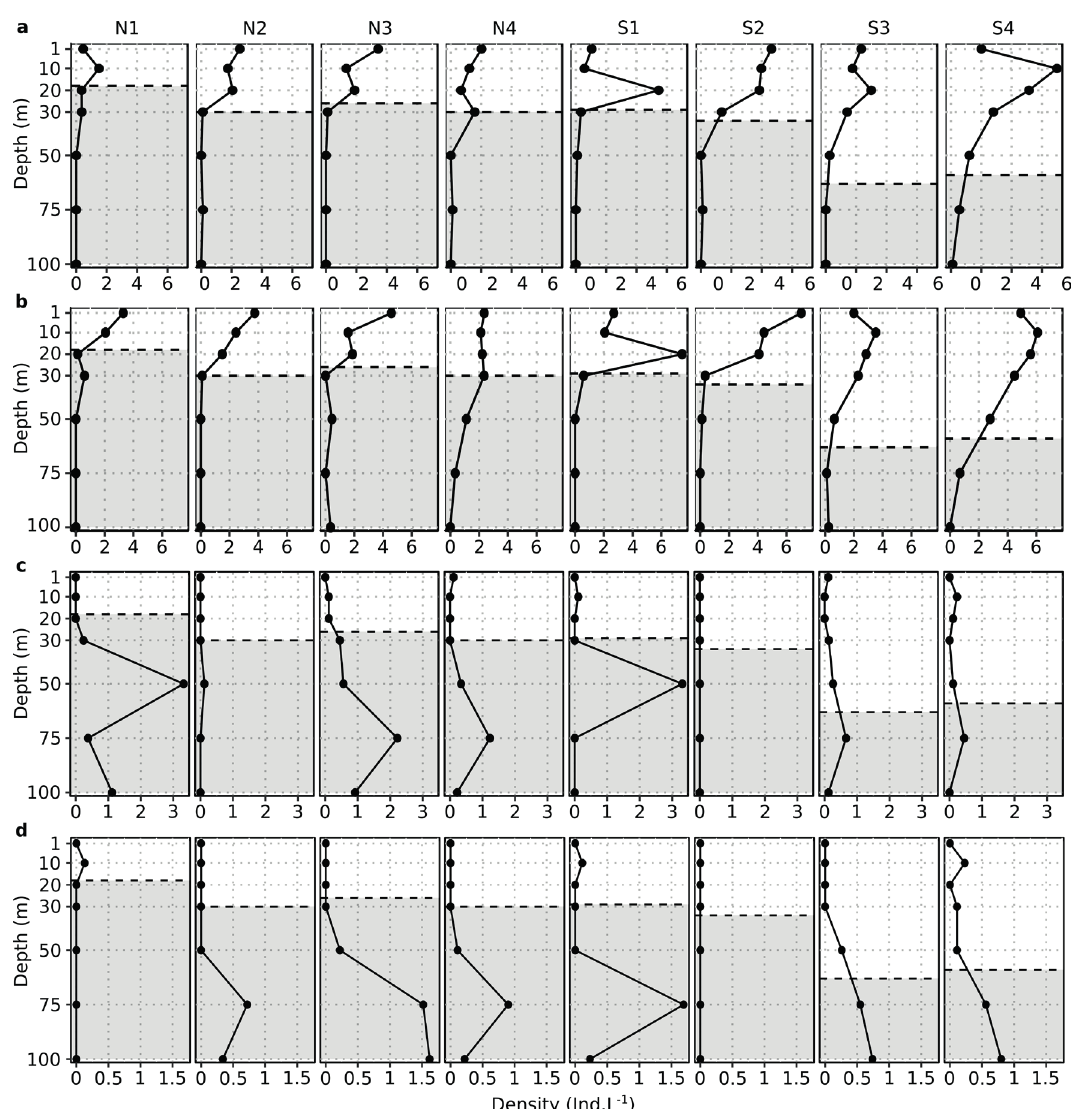
Figure 5 - Vertical profile of two indicator species of the SML, the dinoflagellate Tripos declinatus ( a ) and the dinoflagellate Tripos teres ( b ); and two indicator species of the SSL, the tintinnid ciliate Dictyocysta lepida ( c ) and a non-identified Dictyocysta tintinnid ciliate ( d ). The SML was indicated exclusively by dinoflagellates, and the SSL by dinoflagellates and tintinnid ciliates.